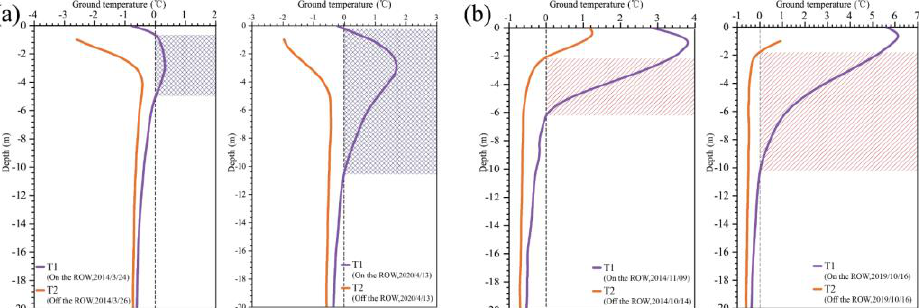
Figure 3. Ground temperature-depth profiles of borehole T1 and T2 in ( a ) cold seasons and ( b ) warm seasons. The rectangles in grey represent the thawing interlayer in cold seasons, and the rectanglesin red represent the thawed permafrost layer in warm seasons.